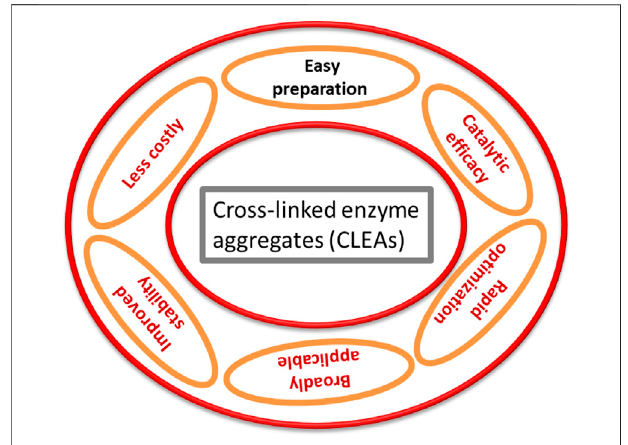
FIGURE 2 | Features of cross-linked enzyme